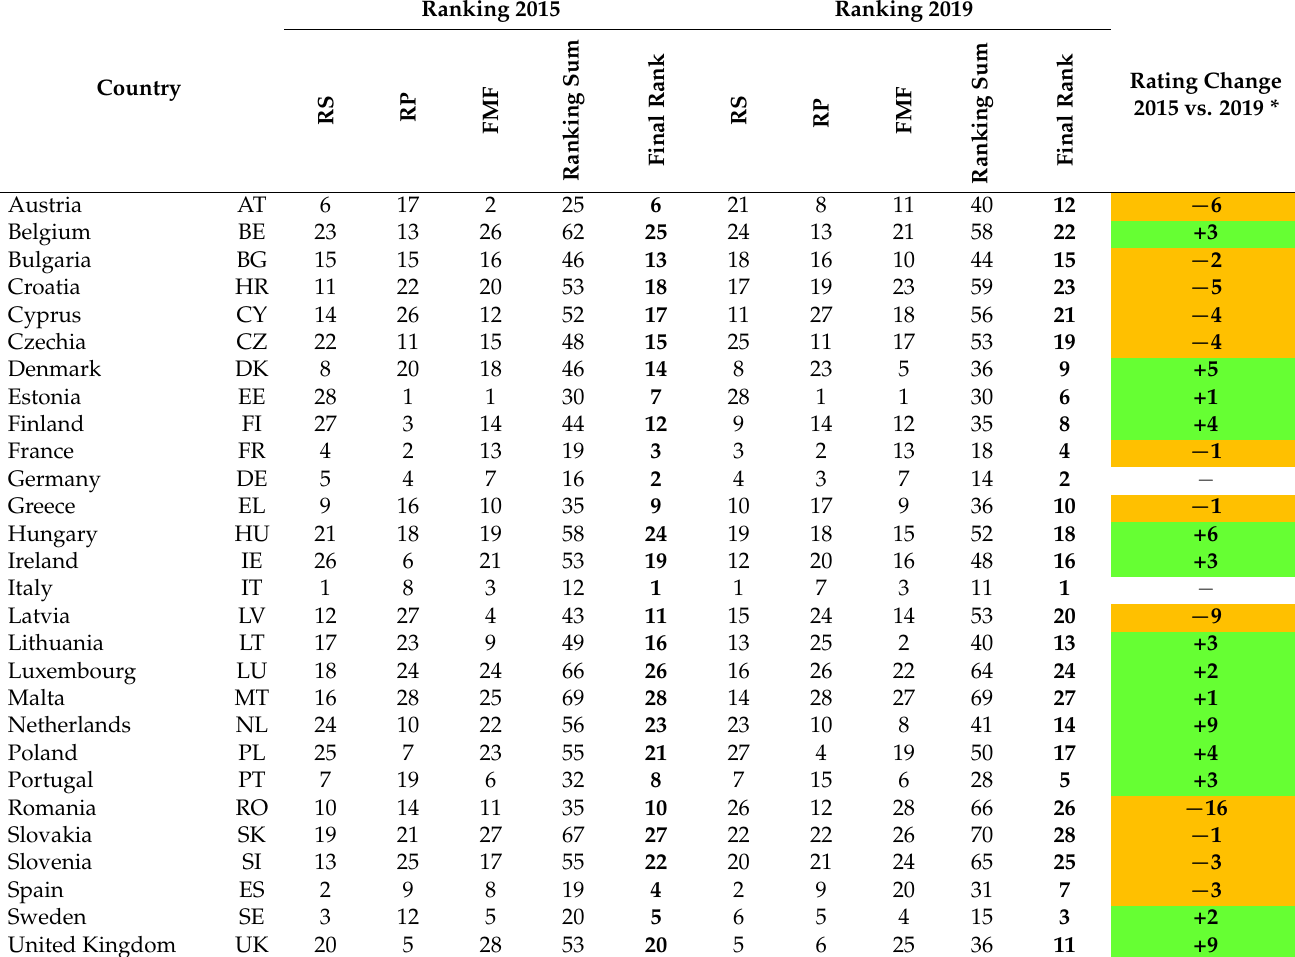
Table 5. MULTIMOORA ranking of management of renewable energy consumption in EU countries 2015. vs. 2019.